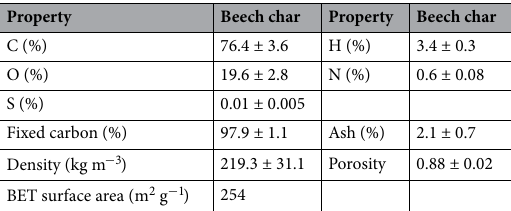
Table 3. Properties of char samples. a Proximate analysis of bone dry char as per ASTM Standards: ASTM E872, E1534. b Porosity is calculated based on non-porous carbon